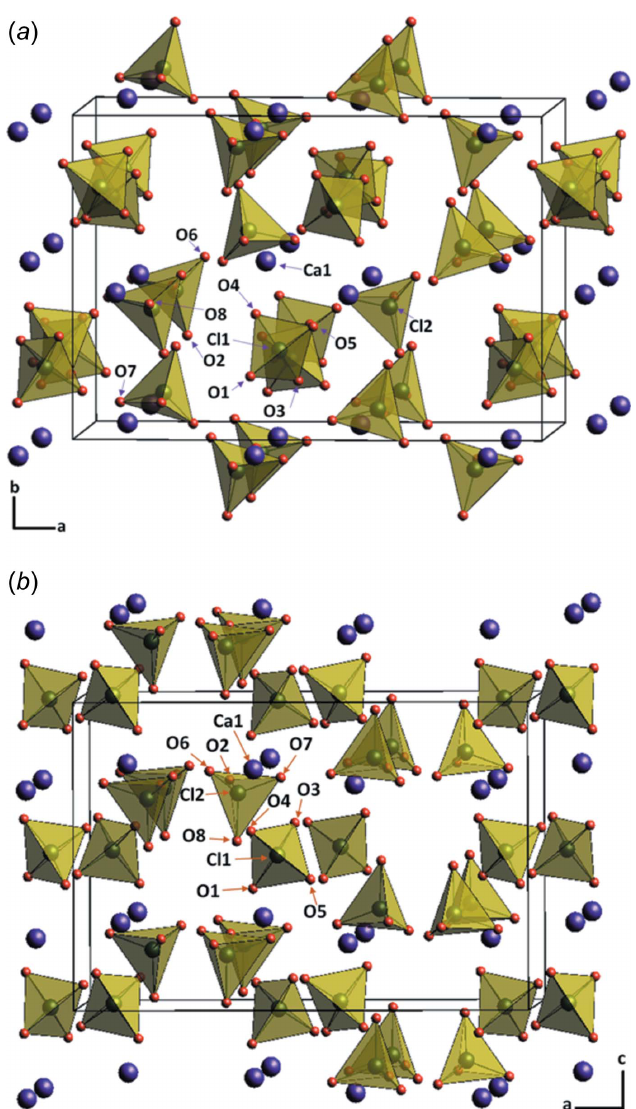
Figure 2 The crystal structure of Ca(ClO 4 ) 2 with ClO 4 (cid:3) tetrahedra (yellow) and Ca 2+ cations (purple), showing ( a ) a view approximately along [001] and ( b ) approximately along [010].